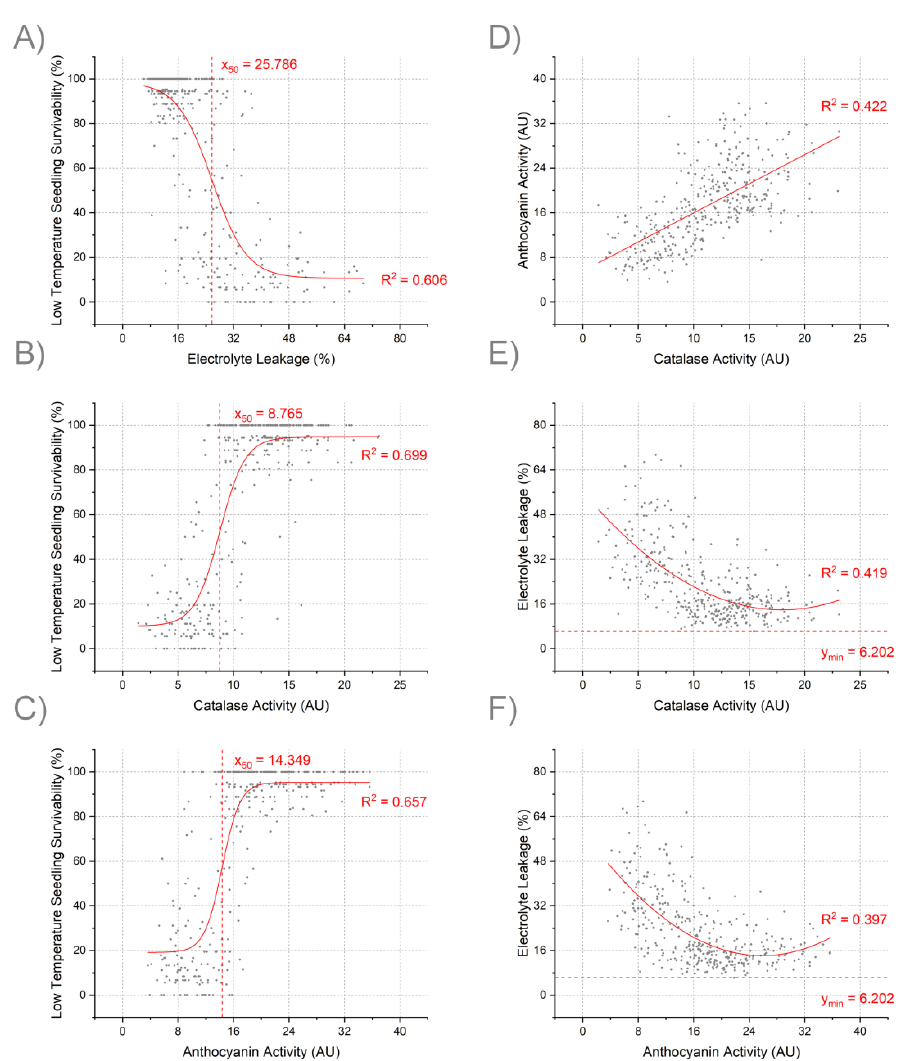
Figure 3. Correlation analyses of four chilling tolerance phenotypes after a 7-day-10 °C treatment. Each dot shows the correlation for one accession. ( A – C ) Correlations between LTSS and EL, CAT, and ANT, respectively. A Boltzmann Sigmoid fit is shown based on best-fit model calculations. X 50 and the line y = X 50 show values at which EL, CAT, ANT are halfway between high LTSS and low LTSS. ( D ) Correlations between CAT and ANT activities. A linear fit is shown based on best-fit model calculations. ( E , F ) Correlations between EL, and CAT and ANT, respectively. An Exponential Decay fit is shown based on best-fit model calculations. The line x = y min shows the lowest EL value after reaching the plateau for the curve.